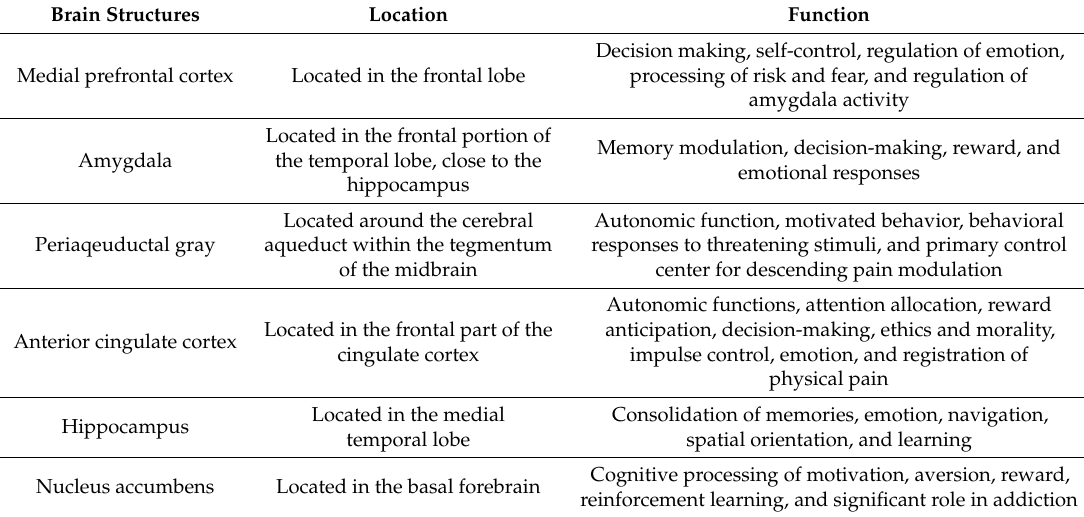
Table 1. Corticolimbic structures associated with chronic